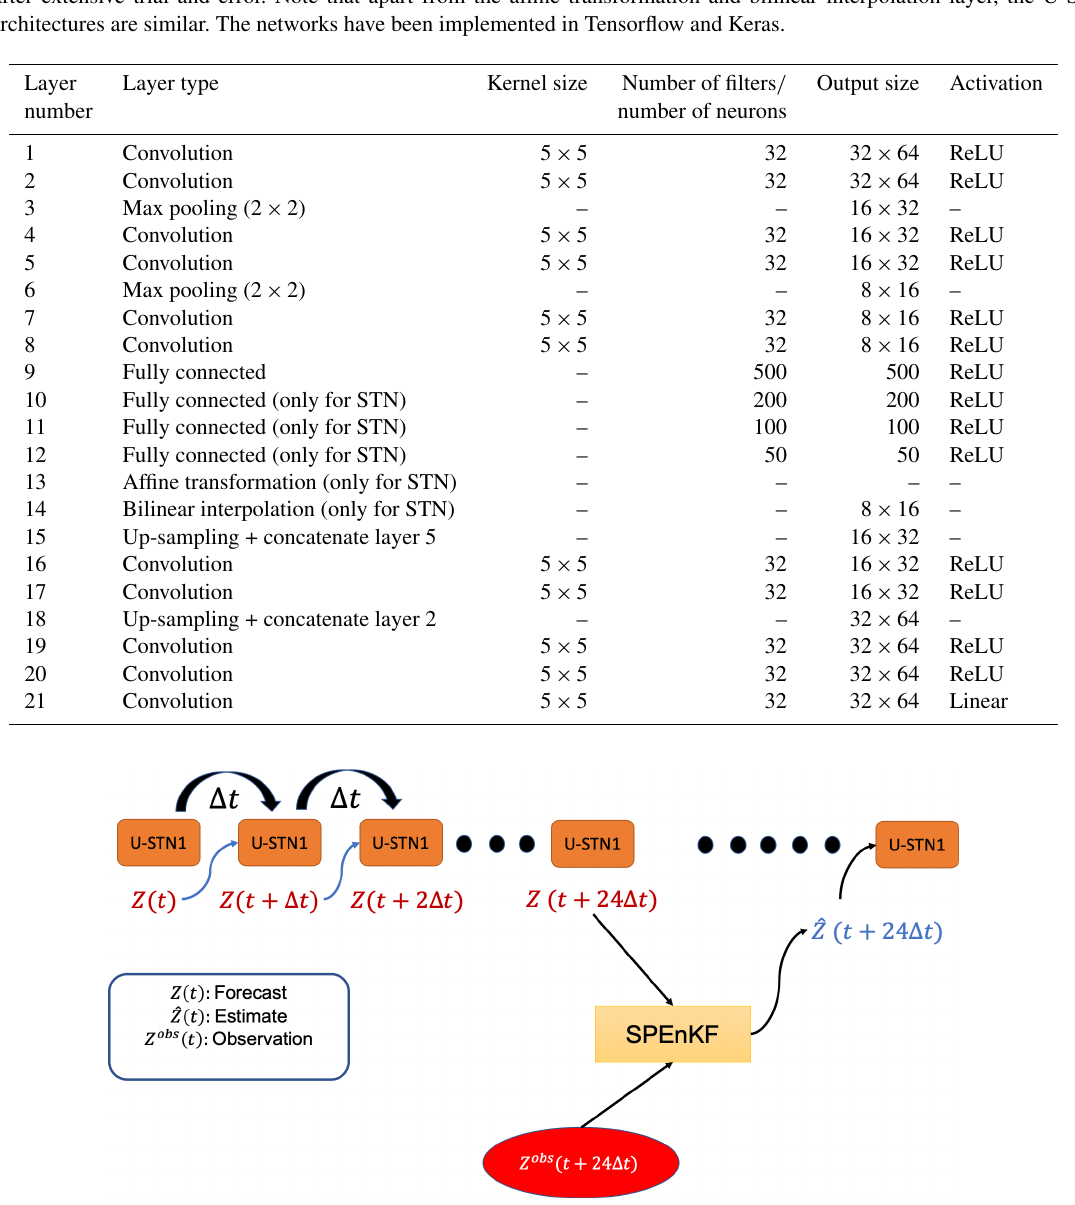
Figure 2. The framework for a synergistic integration of a DA algorithm (SPEnKF) with a DDWP (U-STN1). Once the DDWP+DA frame- work is provided with a noisy Z(t) , it uses U-STN1 to autoregressively predict Z(t + 23 (cid:49)t) . A large ensemble is then generated using Eq. (4), and for each member k , Z k ens (t + 24 (cid:49)t) is predicted using U-STN1. Following that, an SPEnKF algorithm assimilates a noisy observation at the 24thh to provide the estimate (analysis) state of Z500, ˆ Z(t + 24 (cid:49)t) . U-STN1 then uses this analysis state as the new initial condition and evolves the state in time, with DA occurring every